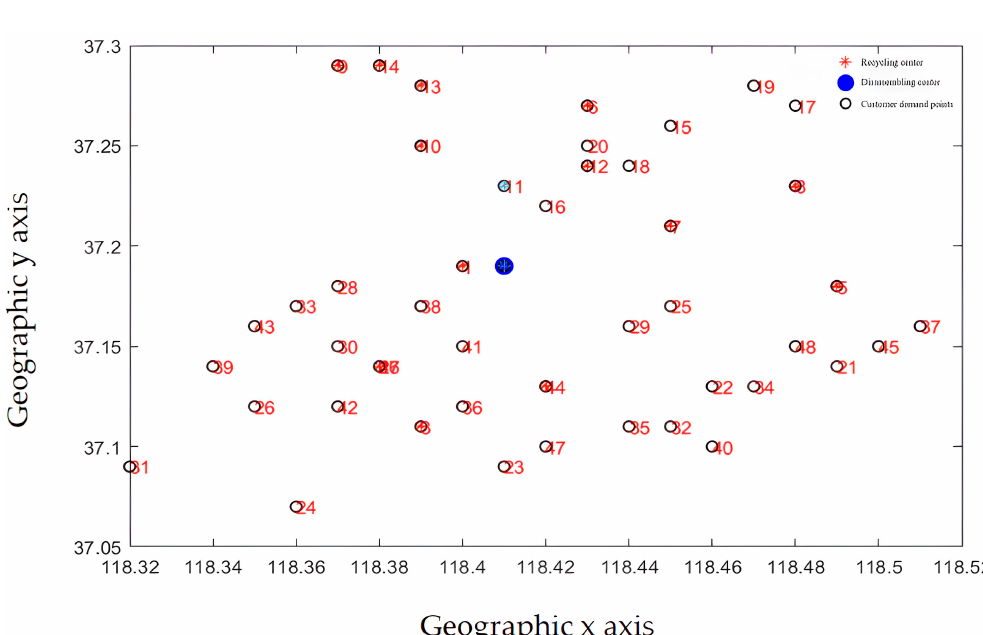
Figure 12. Location results.